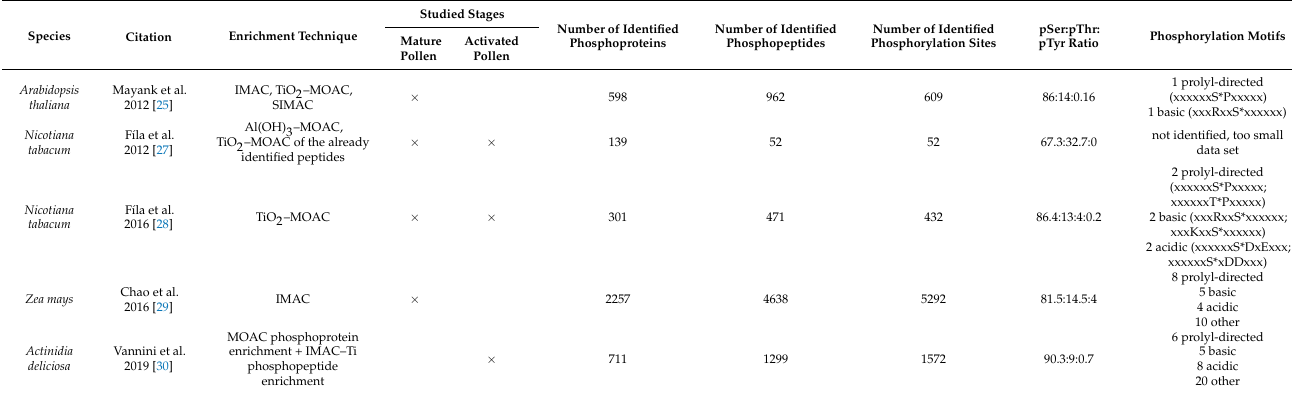
Table 1. Summary of the publications that presented angiosperm male gametophyte